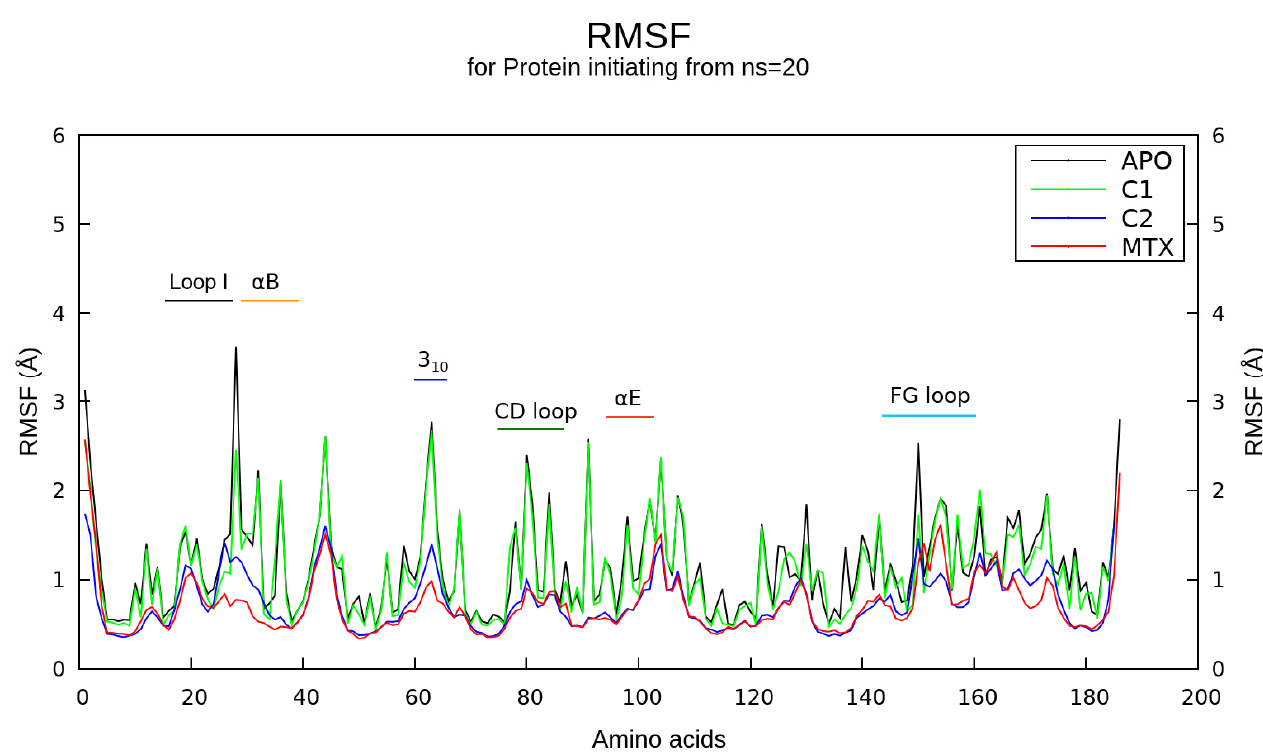
Figure 4. Average RMSF plot for hDHFR in a bound and unbound form. The per-residue RMSF calculation for the free or unbound form, as well as the bound form complexed with C1, C2, and MTX, are depicted by continuous lines in a black, green, blue, and red color, respectively. Specific secondary structures are reported at the top of the graph.